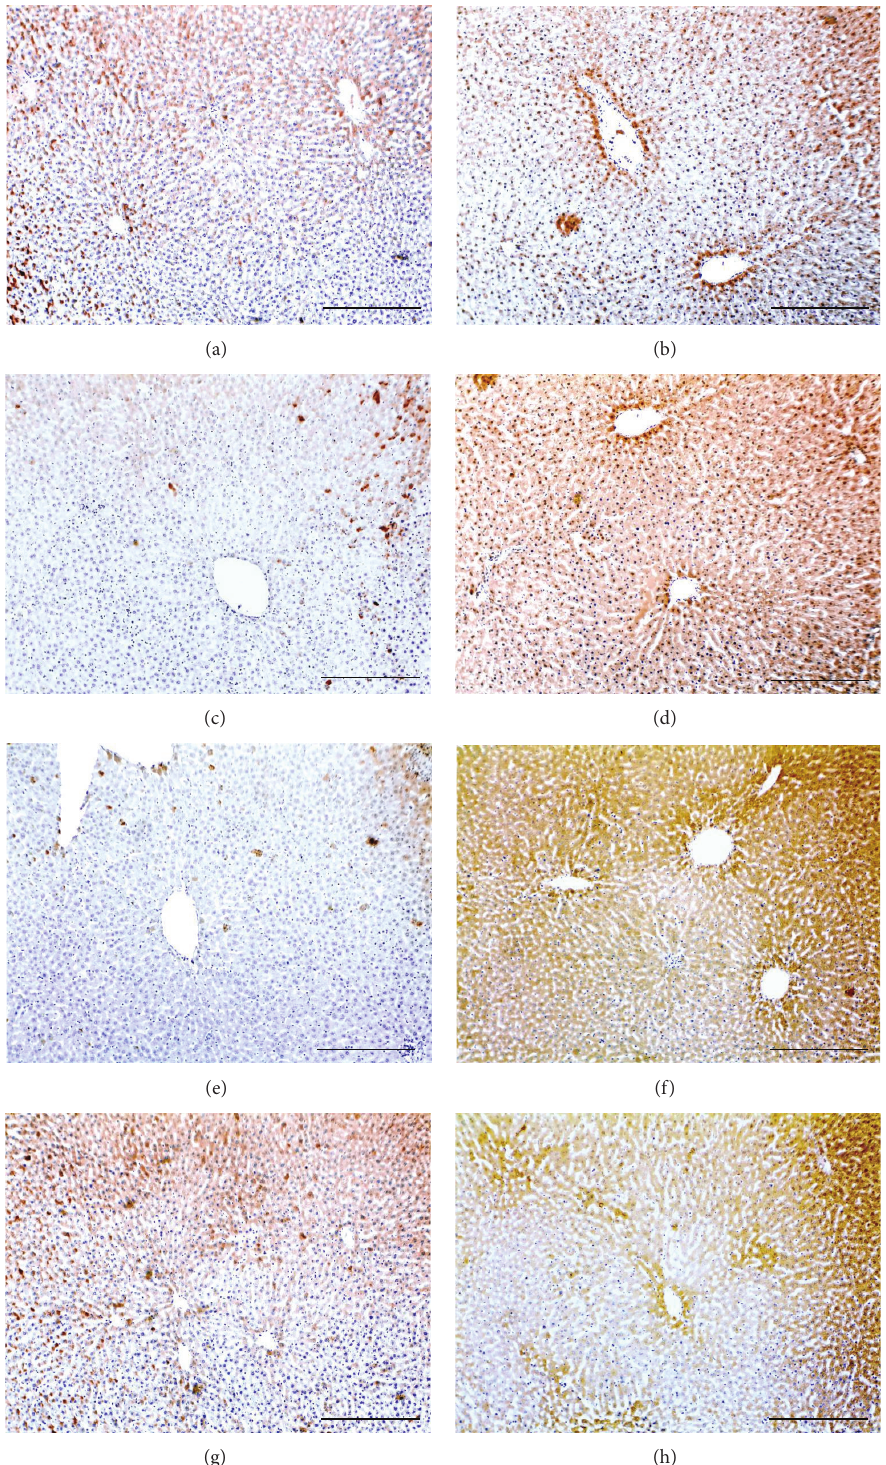
Figure 1: Immunohistochemistry localisation of activin 𝛽 A-subunit (left column) and follistatin (right column) in control (a and b), Peg-only (c and d), Peg & RBV (e and f), and RBV-only (g and h) groups ( × 100 magnification, scale bar = 15 𝜇